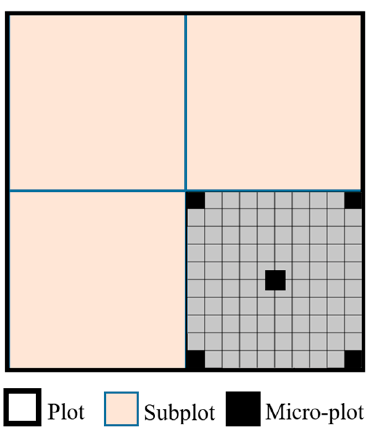
Remote Sens. 2021 , 13 , 1561 Figure 3. An illustration of the 3-level sampling scheme for the surface fuel load inventory.